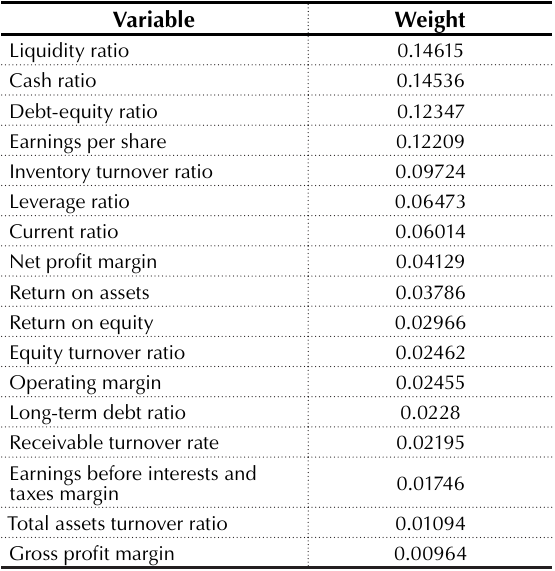
Table 7. Weights of the variables by